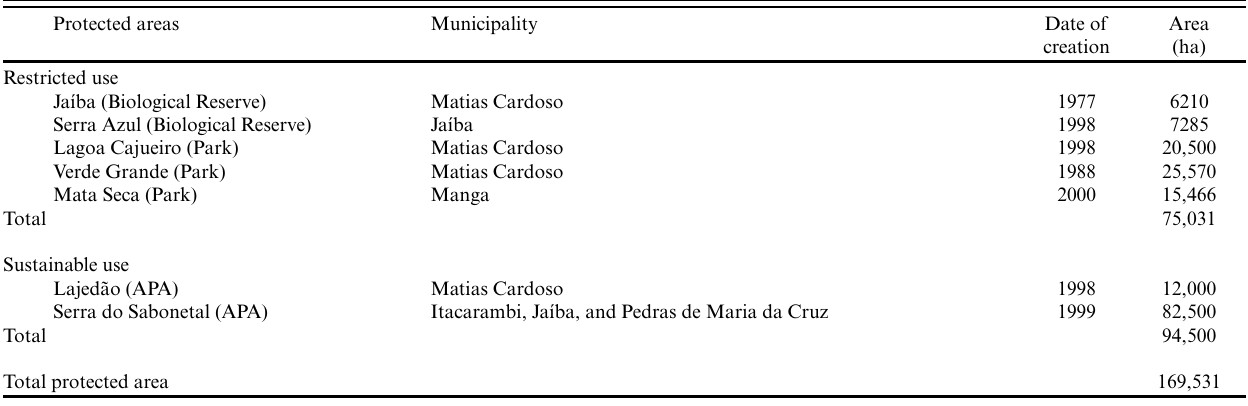
Table 1 . Protected areas (PAs) created as environmental compensation for the Jaíba Project. All PAs are managed by the State Forestry Institute of Minas Gerais and were demanded as a condition for the second phase of the project, with the exception of the Jaíba Biological Reserve. APA = Area of Environmental